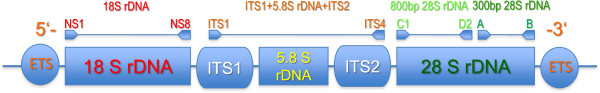
Schematic representation of the 45S rDNA unit and FISH probes construction including primers nesting sites. (not to scale).